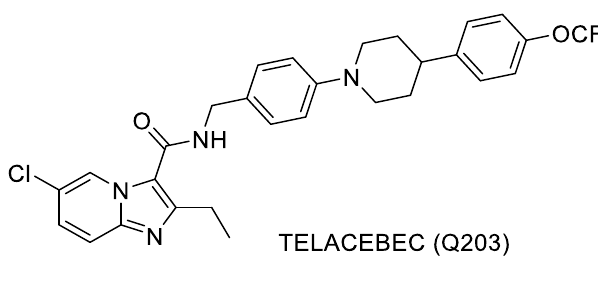
Figure 6. Structure of Telacebec.